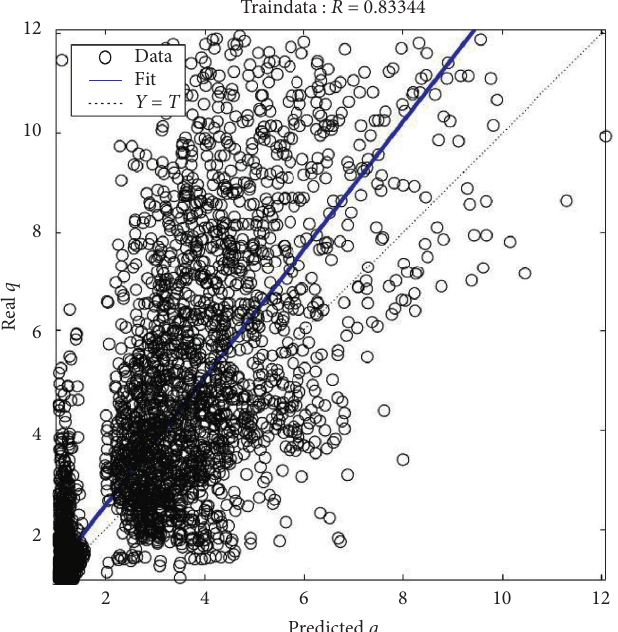
Figure 6: Relationship between the independent parameters ( n